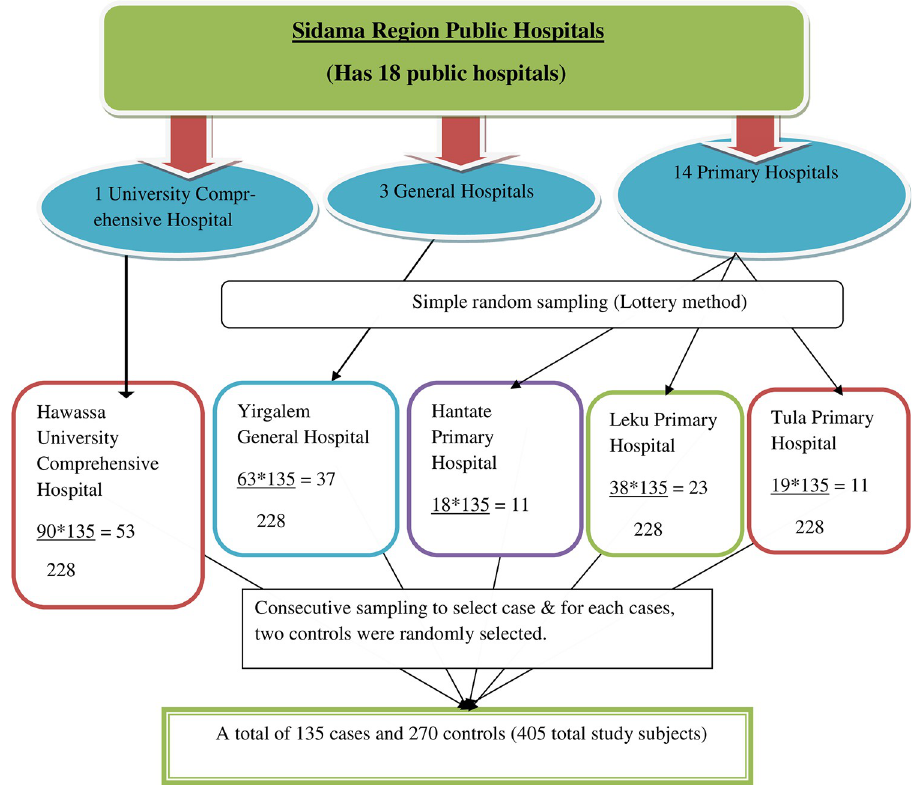
Fig 1. Schematic presentation of sampling techniques and proportional allocation of cases at public hospitals, Sidama region.